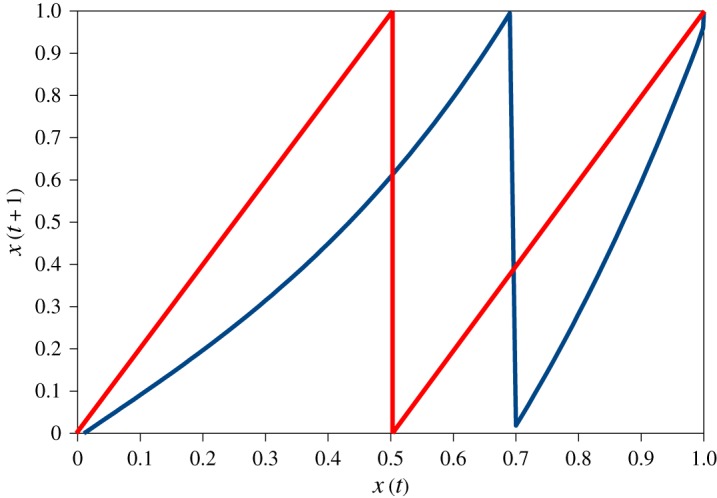
More maps in a box: Bernoulli map (red) and the Pomeau–Manneville map (blue).